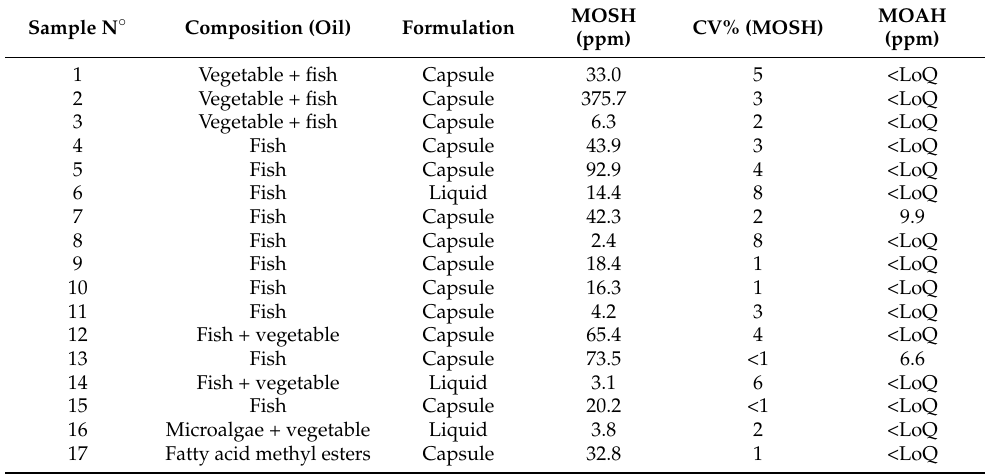
Table 1. List of the analyzed samples along with composition, formulation, MOSH and MOAH contamination levels, and CV%